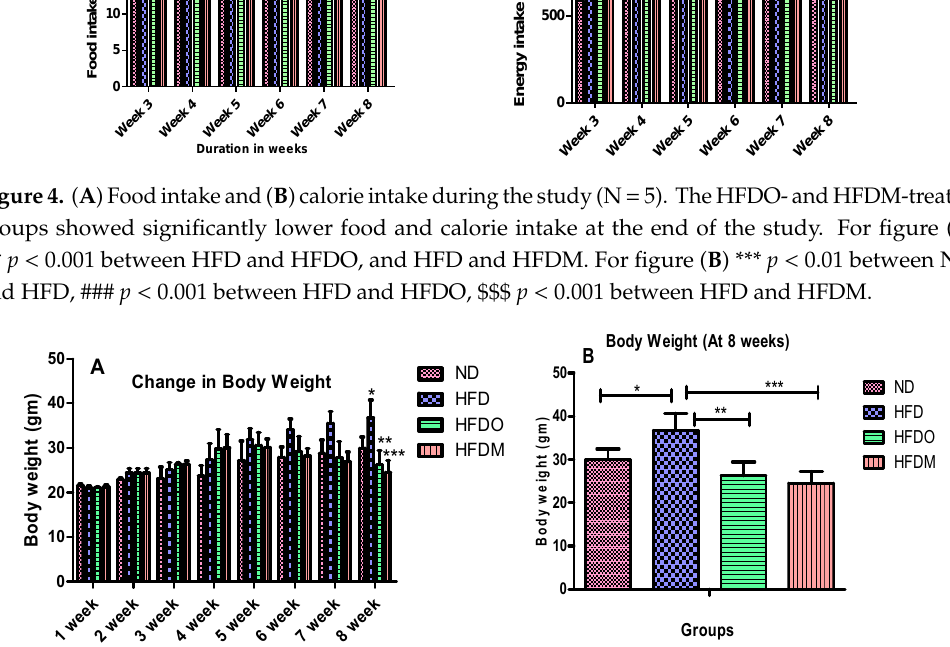
Figure 5. Treatment with MESK reduced the total body weight gain in a high-fat diet-induced obese mouse model. ( A ) Change in body weight during the study and ( B ) comparison of body weight after 8 weeks (N = 5; * p = 0.0120 between ND and HFD, ** p = 0.0018 between HFD and HFDO, *** p = 0.005 between HFD and HFDM). Data are represented as Mean ± standard deviation (SD). (ND: normal diet, HFD: high-fat diet, HFDO: HFD + Orlistat, HFDM: HFD + MESK). 3.3. Effect of MESK on the Weight of Epididymal Adipose Tissue (EAT) and Liver Weights of both EAT and liver were higher in the HFD-treated group (Figure 6A,B) when compared with the normal diet group. However, HFD + Orlistat (HFDO) and HFD + MESK (HFDM) groups